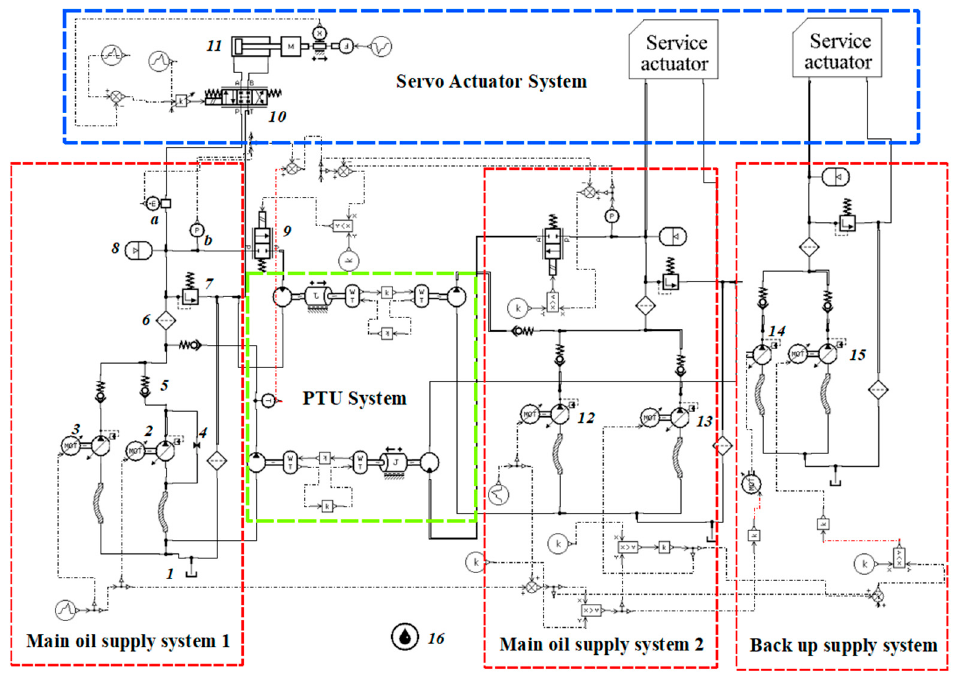
Figure 5. Simplified model of an aircraft hydraulic system by Amesim.